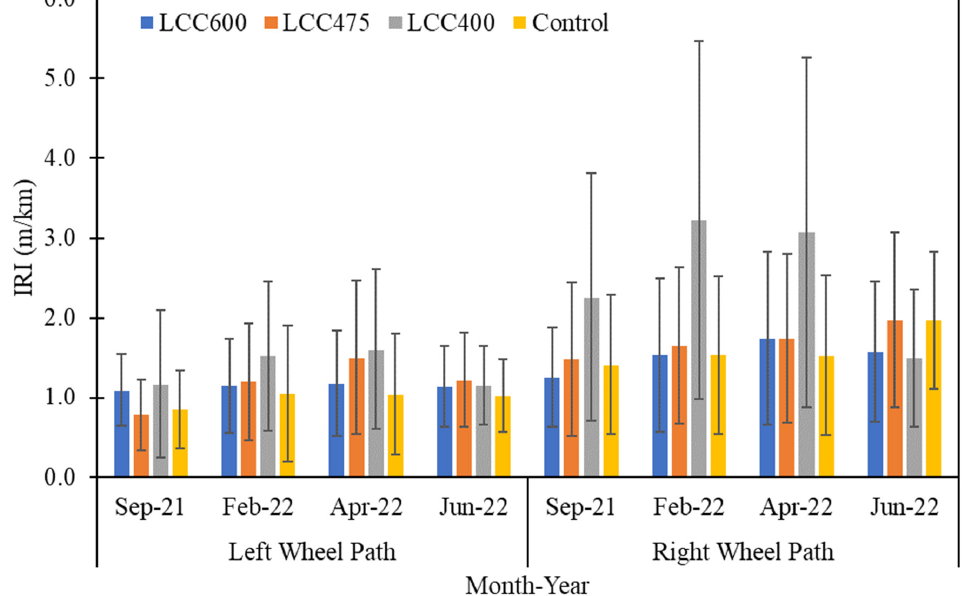
Figure 13. Notre Dame Drive Southbound Lane measured IRI.